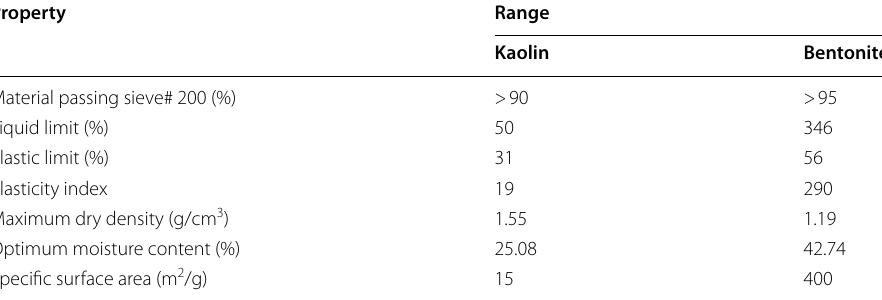
Table 1 Index properties of the kaolin and bentonite used in this study Property Range Kaolin Bentonite Material passing sieve# 200 (%) > 90 >